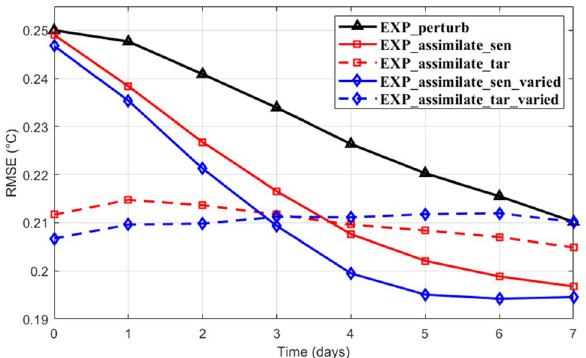
Figure 7. Temporal evolution of the temperature profile RMSEs in the target region during the prediction time among the Observing System Simulation Experiments. Figures are plotted using MATLAB R2017a (http:// www. mathw orks. com/).